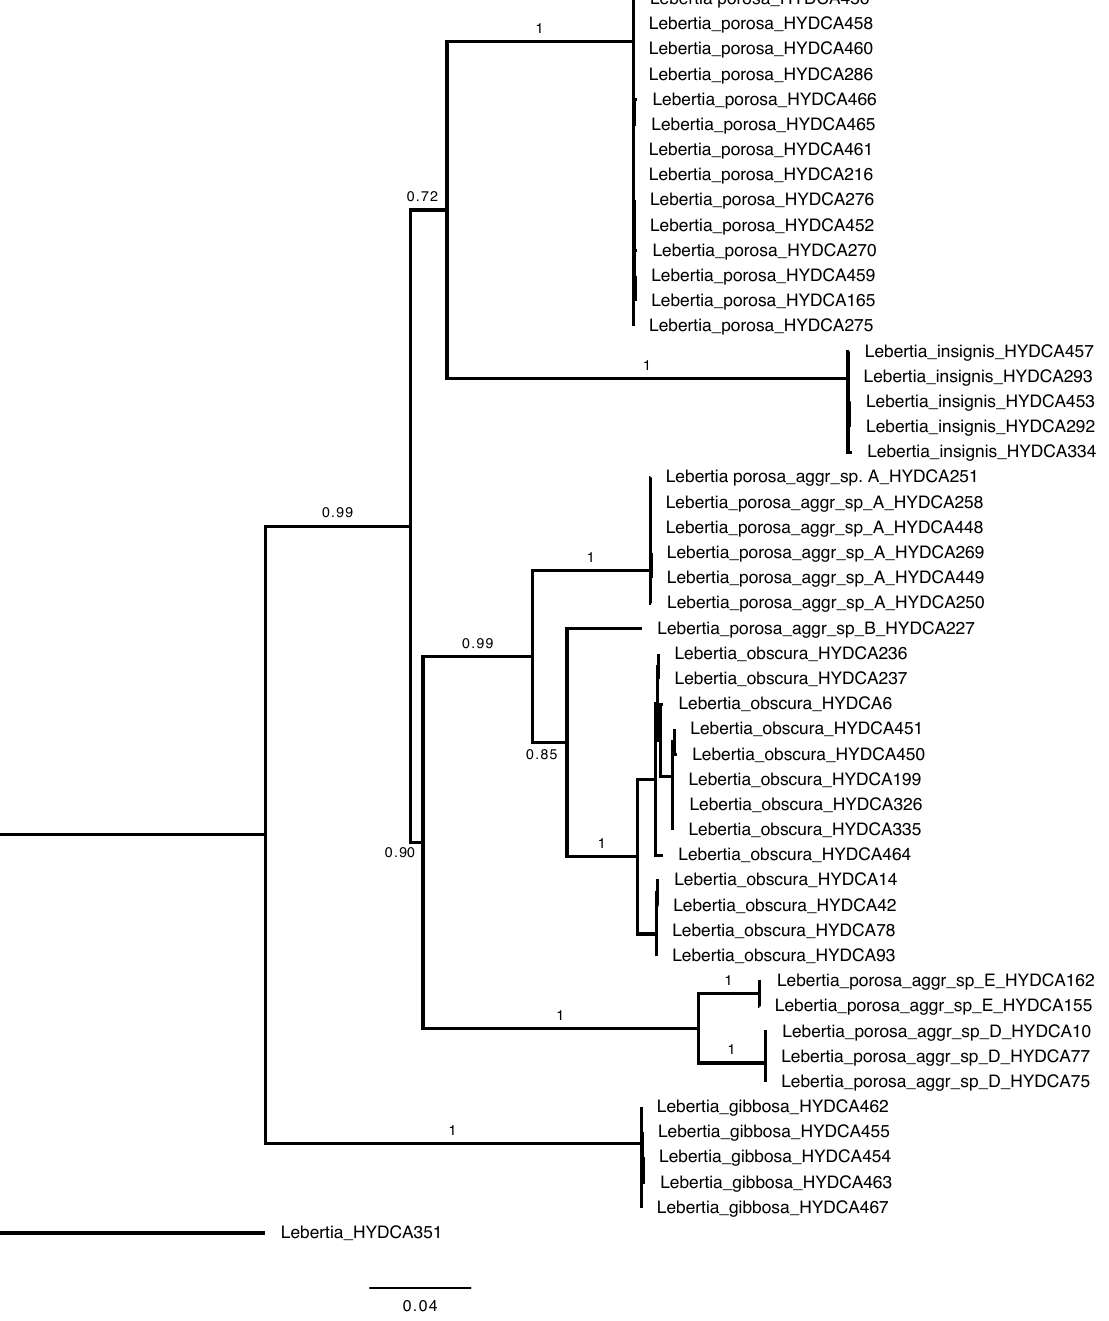
Fig. 4. Lebertia ( Pilolebertia ) spp. in Norway. Maximum Likelihood tree from analysis of the concatenated dataset (COI, 18S, 28S) in RAxML-NG. Bootstrap support (500 replicates) above 50% on